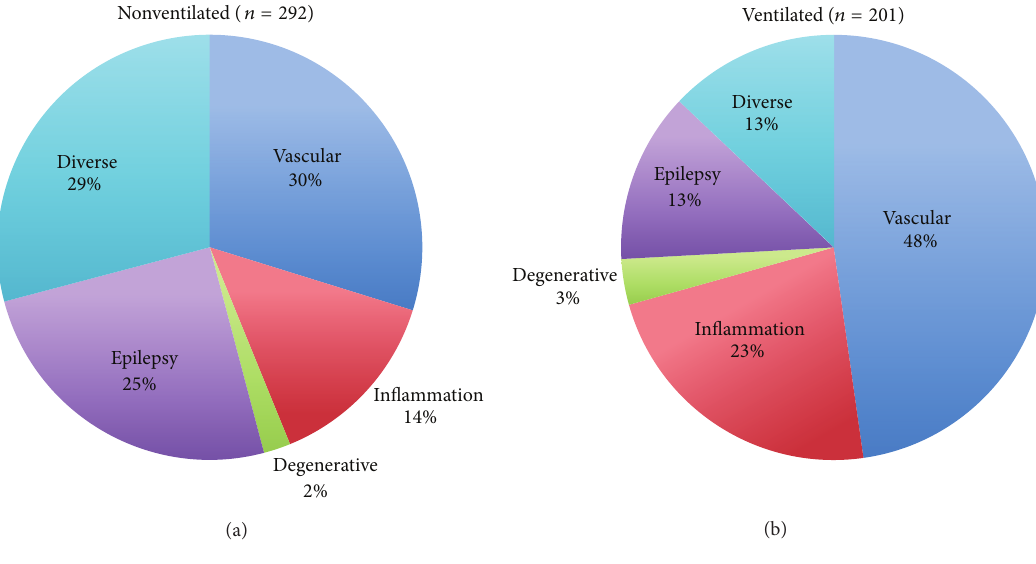
Figure 1: Indications for treatment on